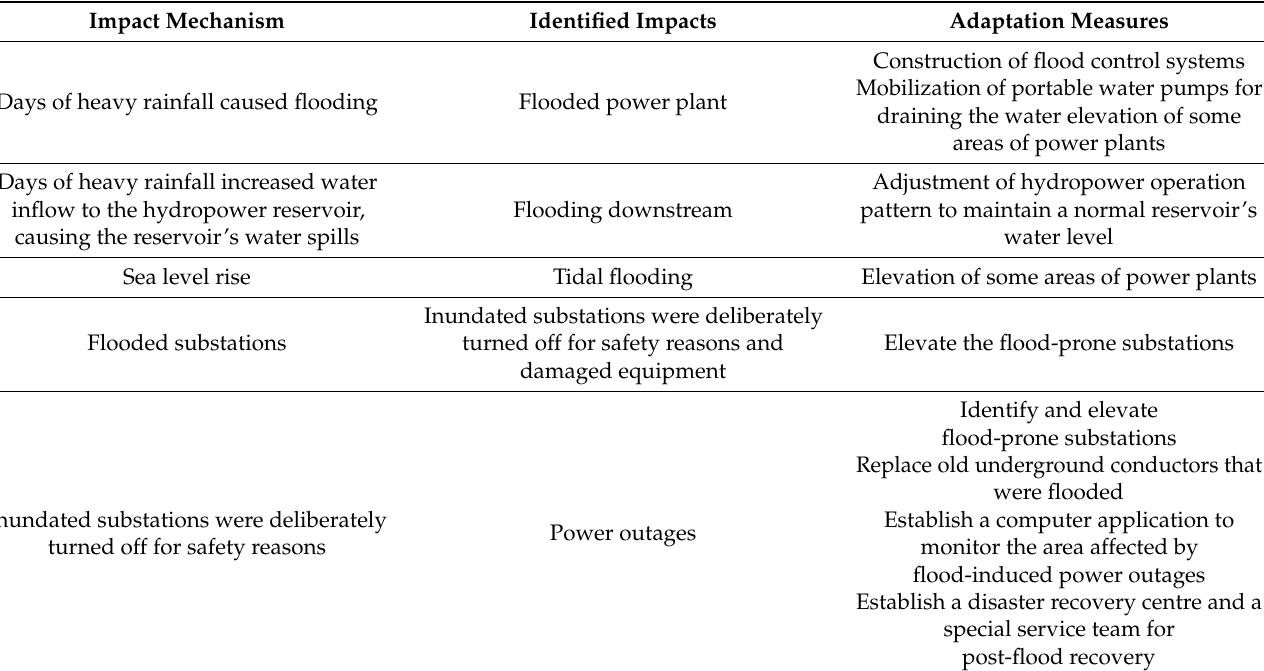
Table 1. Display of the influence of weather on the production, transmission and distribution of